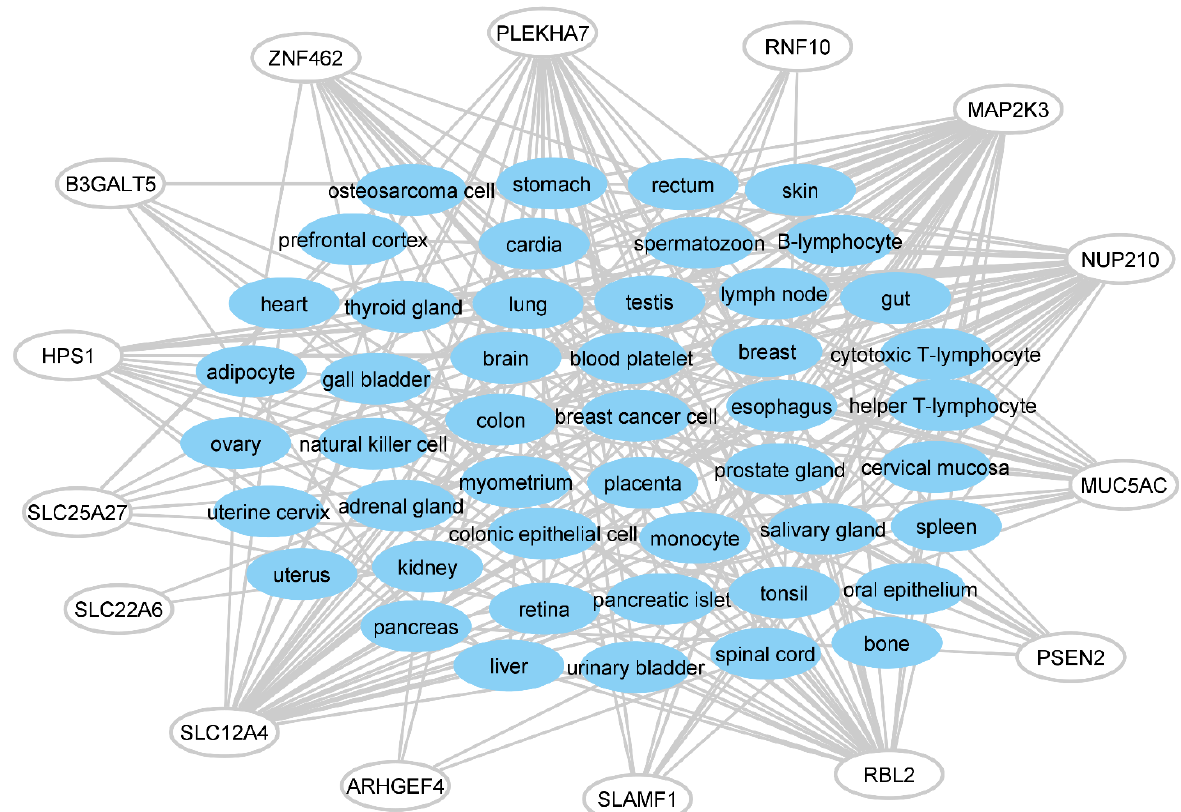
Figure 6. Networks of the identified human proteins with the tissues expressing them. Proteins with the abbreviations in the figure: Beta-1,3-Galactosyltransferase 5 (B3GALT5), HPS1 Biogenesis Of Lysosomal Organelles Complex 3 Subunit 1 (HPS1), Mitogen-Activated Protein Kinase Kinase 3 (MAP2K3), Mucin 5AC, Oligomeric Mucus/Gel-Forming (MUC5AC), Nucleoporin 210 (NUP210), Pleckstrin Homology Domain Containing A7 (PLEKHA7), Presenilin 2 (PSEN2), RB Transcriptional Corepressor Like 2 (RBL), Rho Guanine Nucleotide Exchange Factor 4 (ARHGEF4), Ring Finger Protein 10 (RNF10), Signaling Lymphocytic Activation Molecule Family Member 1 (SLAMF1), Solute Carrier Family 12 Member 4 (SLC12A4), Solute Carrier Family 22 Member 6 (SLC22A6), Solute Carrier Family 25 Member 27 (SLC25A27), Zinc Finger Protein 462 (ZNF462). (Identified proteins without the relevant data in the database are not represented in the figures. See Appendix